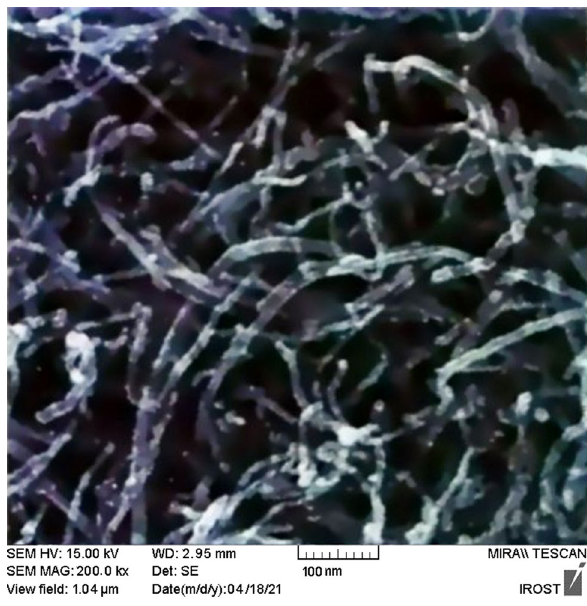
Fig. 1 SEM image of